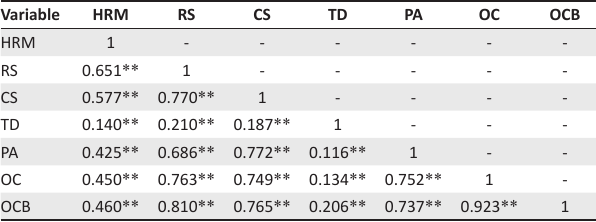
TABLE 6: Correlation between variables.